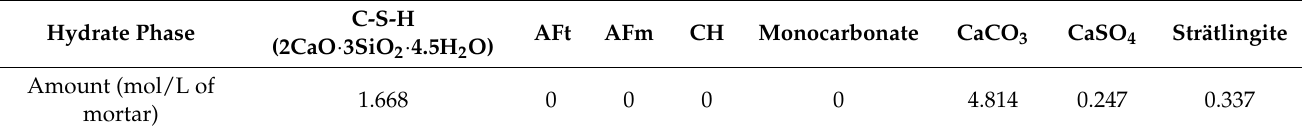
Table 2. Simulation results of the phase composition for the mortar that is completely carbonated.